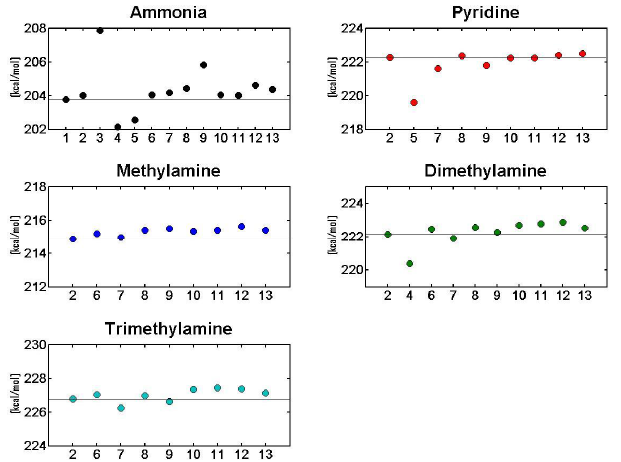
Fig. 1. Benchmark results. Values on the y axis are in kcalmol − 1 . Values on the x axis are labels corresponding to the numbers as- signed to different sources and methods in Table 1. Horizontal lines Figure 1. Benchmark results. Values on the y-axis are in kcal/mol. Values on the x-axis are 3 mark the PA value given in NIST, except in the case of ammonia, labels corresponding to the numbers assigned to different sources and methods in Table 1. 4 where it marks the PA value calculated by Czakó et al. (2008). Horizontal lines mark the PA value given in NIST, except in the case of ammonia, where it 5 marks the PA value calculated by Czakó et al. (2008) 6